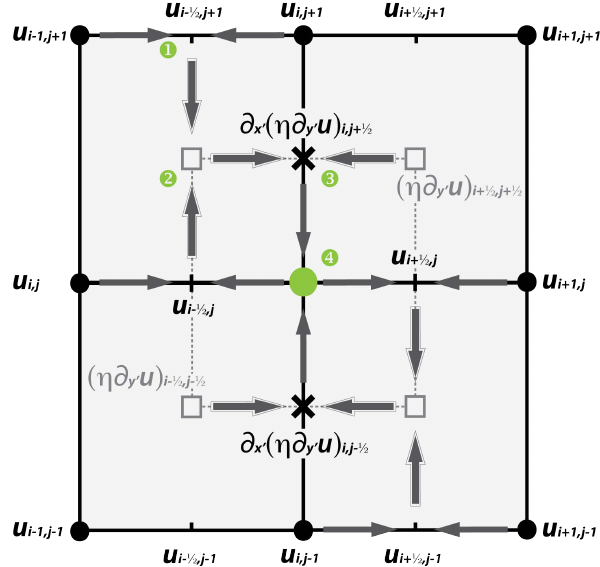
Fig. 2. Visualization of the operating mode of 9(x,y,u,η) . In a first step, two adjacent velocities are averaged in x -direction. This field is then used to form the inner derivative in y -direction that is asso- ciated with the grid point staggered in the x,y -plane (step 2). After determining the viscosity in this point, the outer x -derivative can be computed in a third step. The fourth and last step is to average the resultant field in x -direction (a detailed description is presented in Appendix